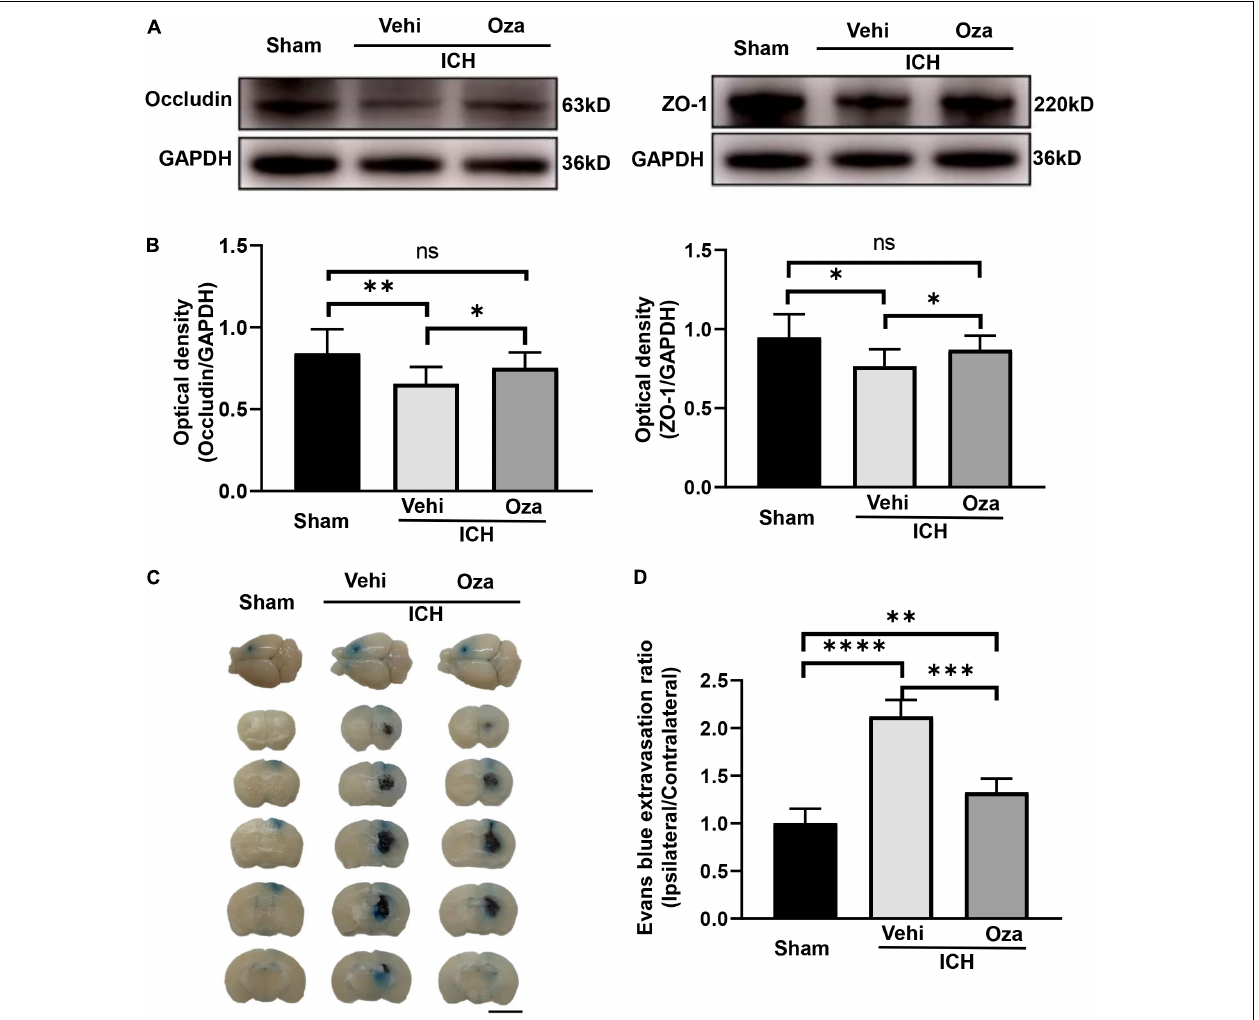
FIGURE 6 | The effects of Ozanimod on blood–brain barrier permeability in mice after ICH. (A) Representative Western blotting images of ZO-1 and Occludin expression with and without Ozanimod treatment. (B) Quantitative analysis of ZO-1 and Occludin protein expression ( n = 3). (C) EB dye extravasation into tissue is apparent in coronal cross section images (Bar = 5 mm). (D) Statistical analysis of EB exudation ( n = 6). Data are presented as mean ± SD . ∗ p < 0.05, ∗∗ p < 0.01, ∗∗∗ p < 0.001, ∗∗∗∗ p <